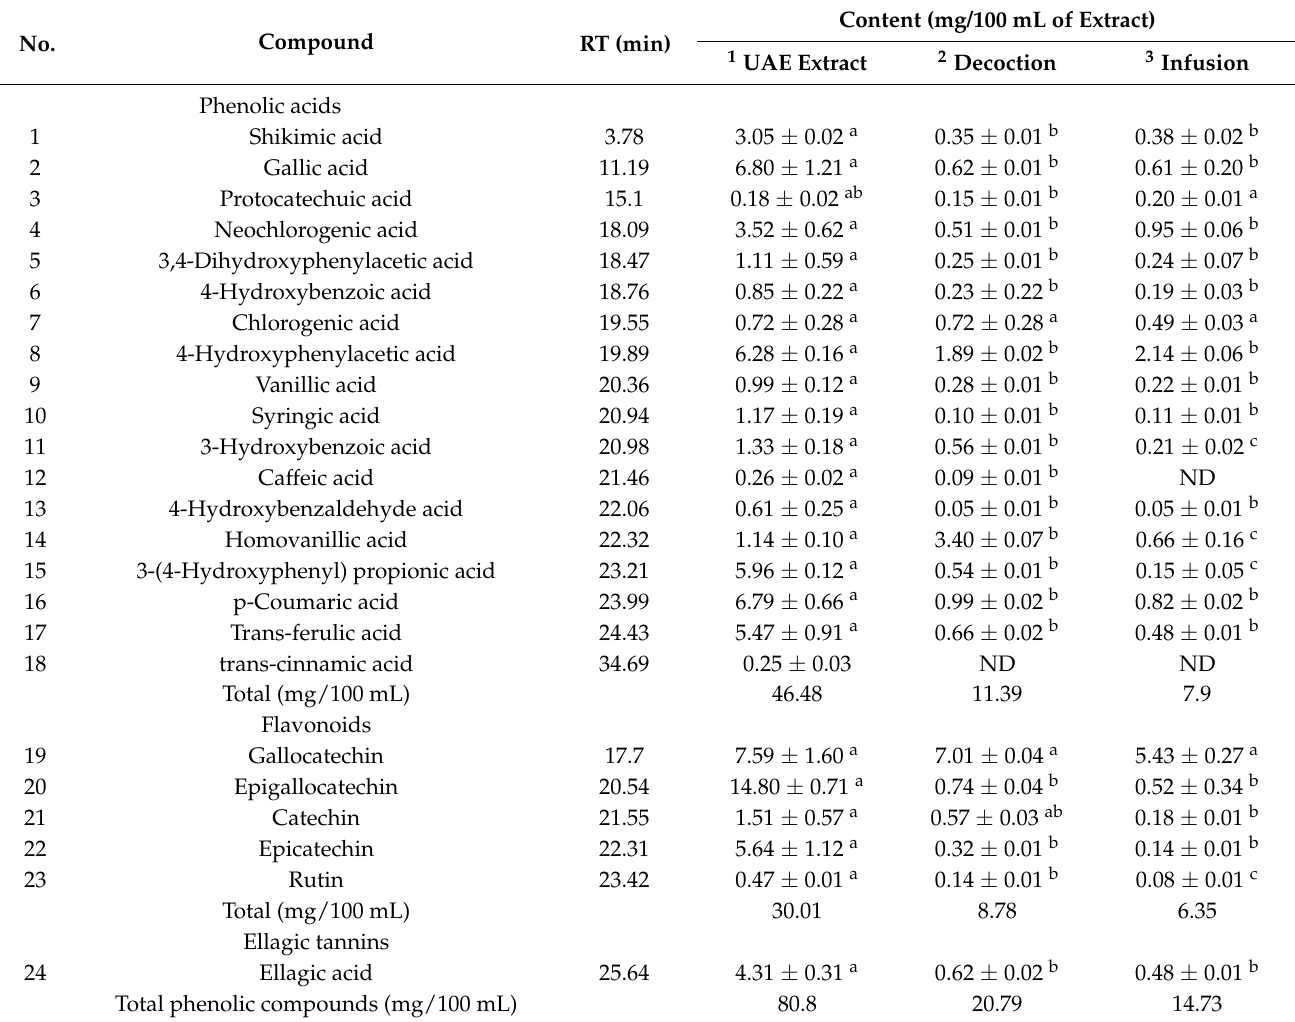
Table 4. Phenolic compounds profile from extracts of Annona muricata leaves obtained by optimal conditions of ultrasound-assisted extraction (UAE), decoction, and